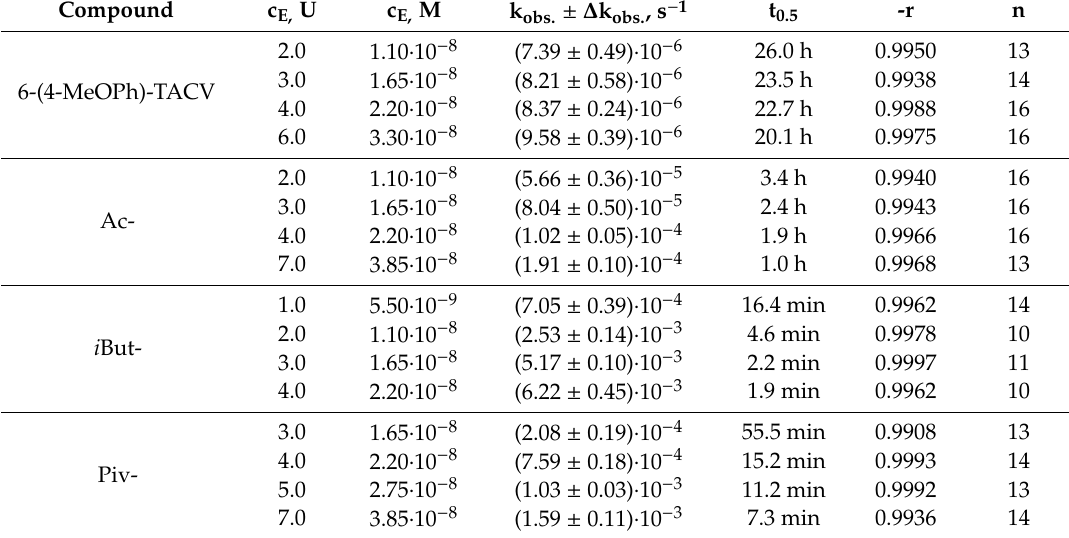
Figure 3. Semi-logarithmic plots of P t = f ( t ) reaction of the hydrolysis reaction of the pivaloyl esters of 6-(4-MeOPh)-TACV ( a ) and ACV ( b ) in plasma (80%, 37 °C) in the presence of porcine esterase. Table 3. The observed pseudo-first-order rate constants for hydrolysis of the tested compounds in plasma (80%, 37 °C) in the presence of porcine esterase.